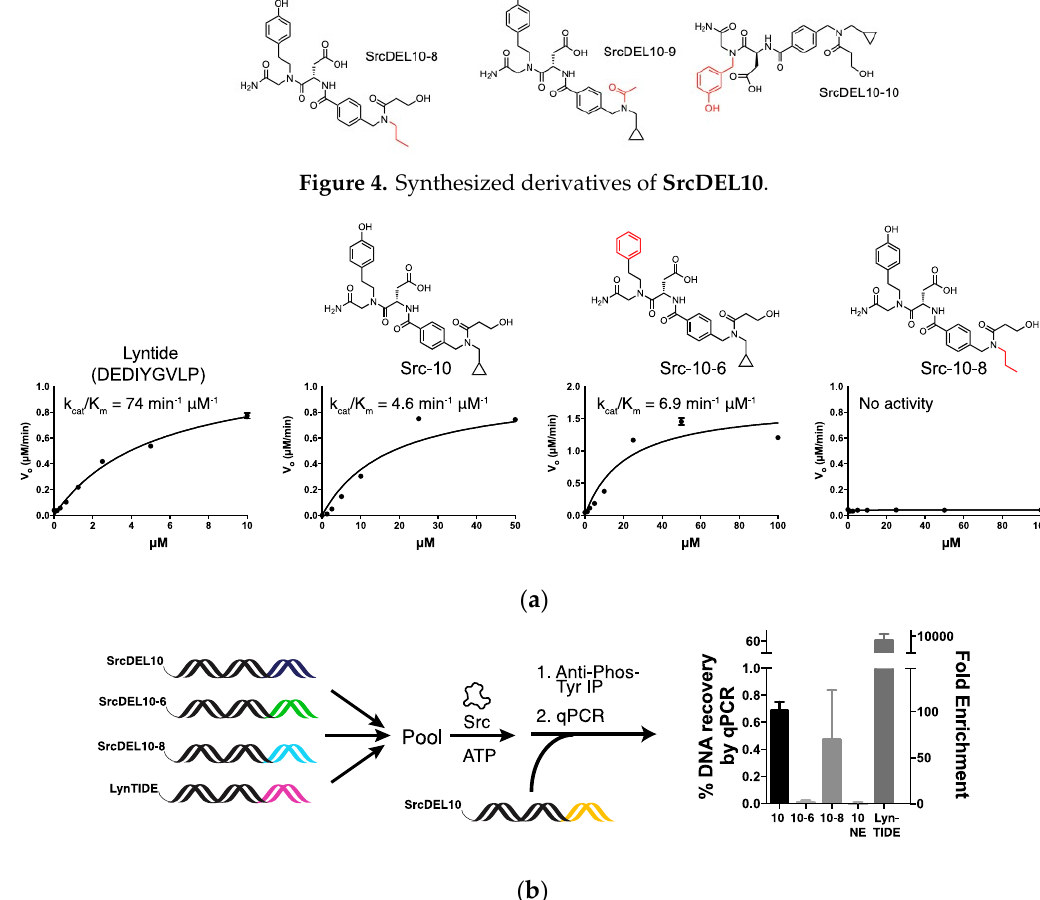
Figure 5. Structure activity relationship (SAR) studies of SrcDEL10 derivatives. ( a ) ADP-Glo assays of the SrcDEL10 derivative, SrcDEL10 – 6 , lacking a phenolic oxygen show comparable activity to SrcDEL10 . Derivative SrcDEL10 – 8 , which contains the phenol but lacks the cyclopropyl group, shows no activity. ( b ) Analysis of enrichment in the substrate selection (shown in Scheme 1) shows the phenol is required for enrichment. (10-NE, SrcDEL10 with no enzyme